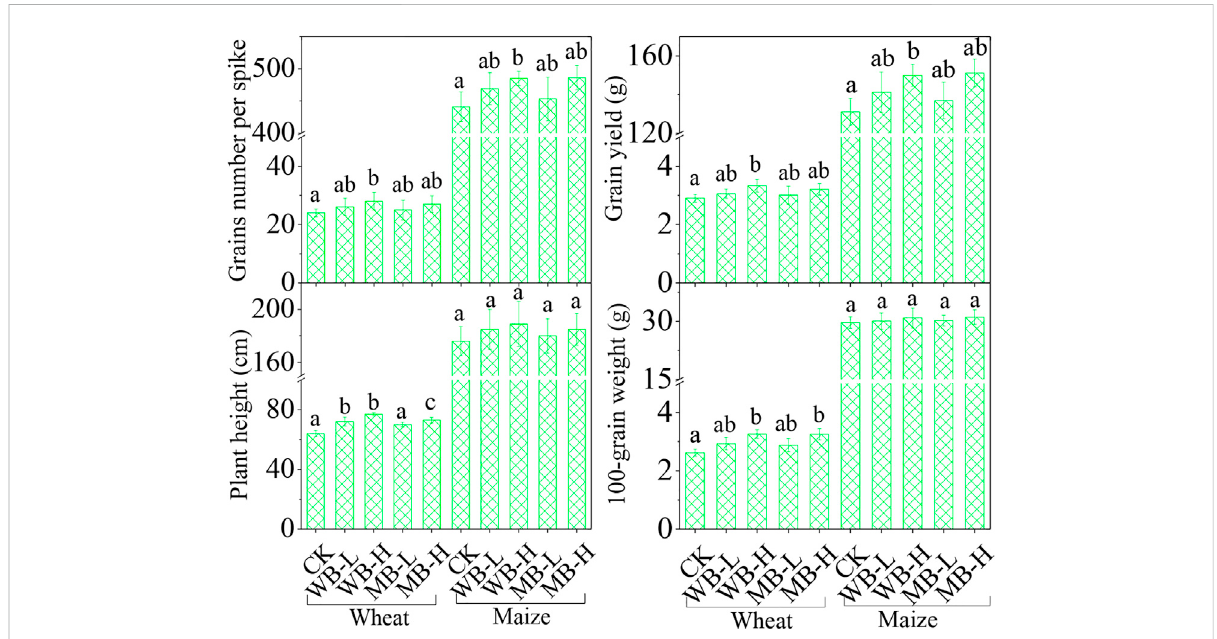
FIGURE 1 Effect of biochar on grain number per spike, grain yield, plant height, and 100-grain weight of wheat and